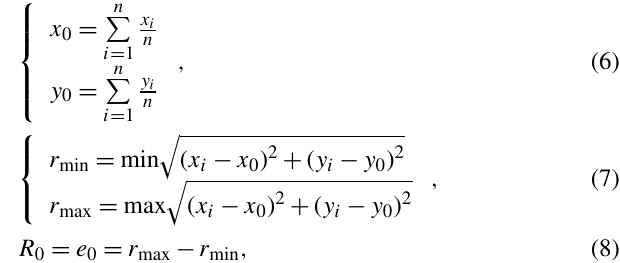
dinates of the circle center are obtained by Eqs. (7) and